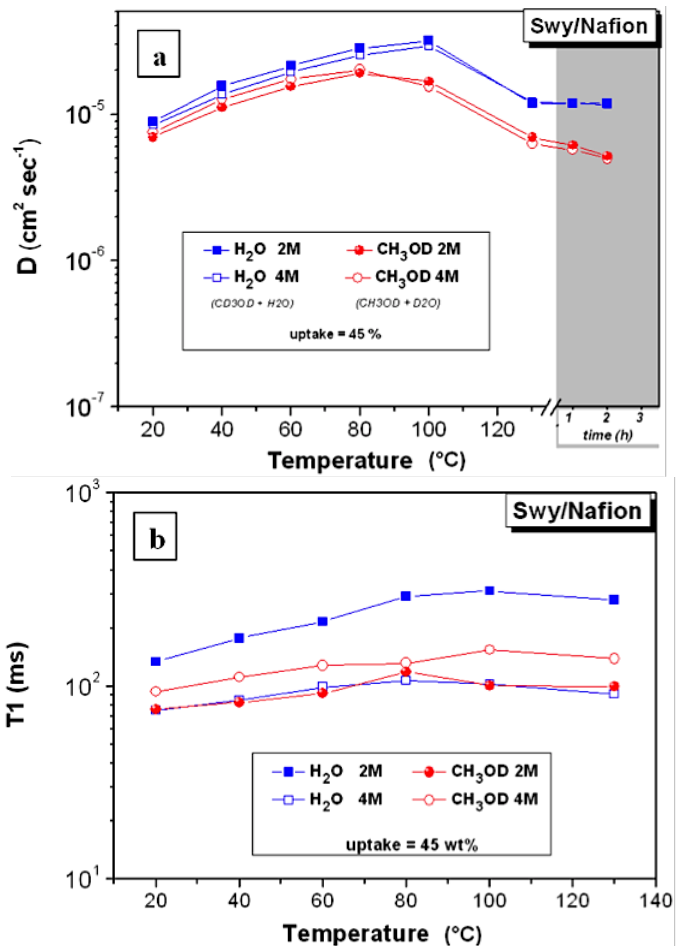
Figure 4. ( a ) Self-diffusion coefficients and ( b ) longitudinal relaxation times (T1) of water and methanol in 2 M and 4 M solutions confined in Swy/Nafion nanocomposite membrane from 20 °C up to 130 °C. Data collected at 130 °C after some hours are also plotted in the diffusion